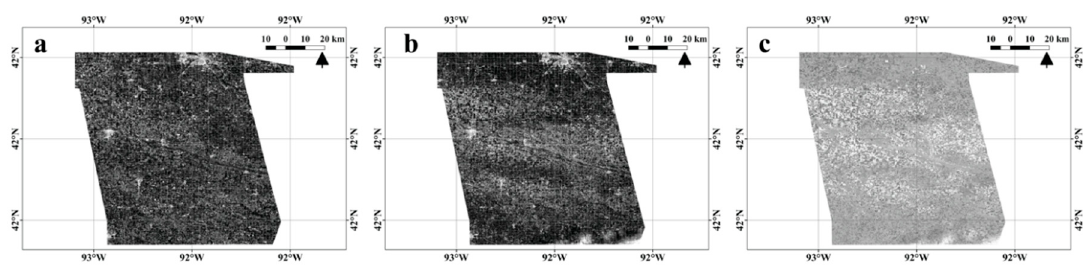
Figure 11. ( a ) Landsat-8 pre-lodging event image acquired on 10 July 2020. ( b )Landsat-8 post-lodging